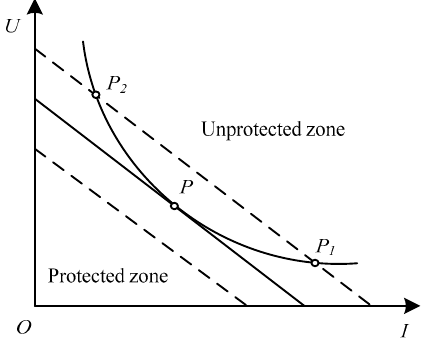
Figure 2. U-I characteristic method for investigating static stability of fault arc.